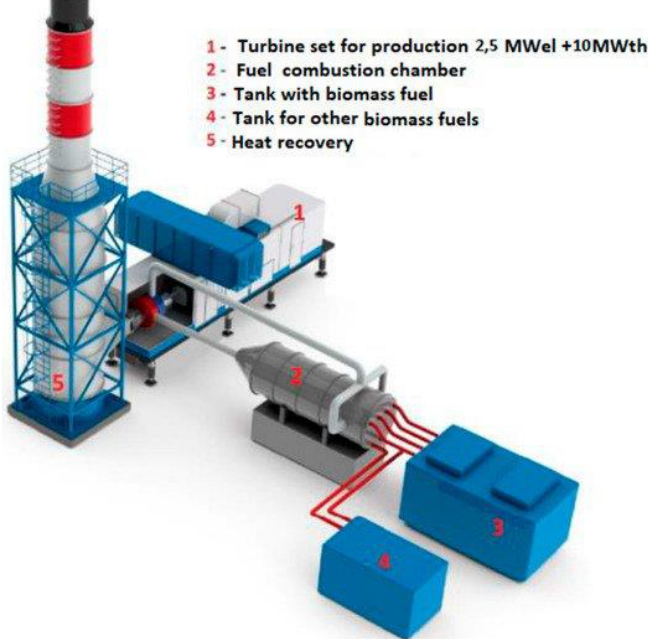
Figure 2. Scheme of a biomass-fired power plant [10].